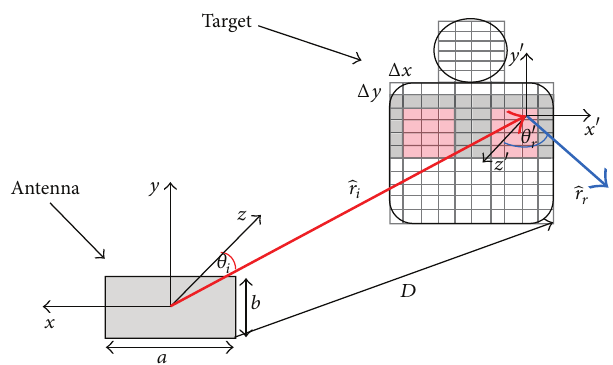
Figure 10: Geometry of the antenna and the